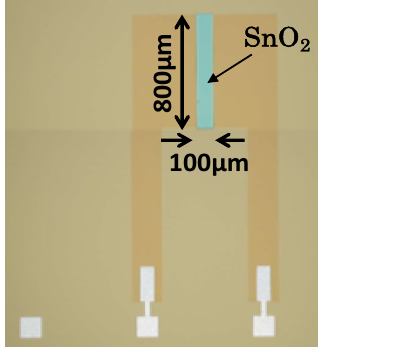
Figure 2. Cross-section diagram showing the fabrication process of the proposed device. ( a ) Sacrifi- cial oxide formation and channel stopper ion implantation. ( b ) Source/drain ion implantation. ( c ) A new layer of gate oxide (SiO 2 ) is formed. ( d ) Deposition of Si 3 N 4 , and source/drain contact opening. ( e ) Aluminum contact sputtering. ( f ) Deposition of SnO 2 on top of a photoresist mask. ( g ) Lift-off of photoresist mask.